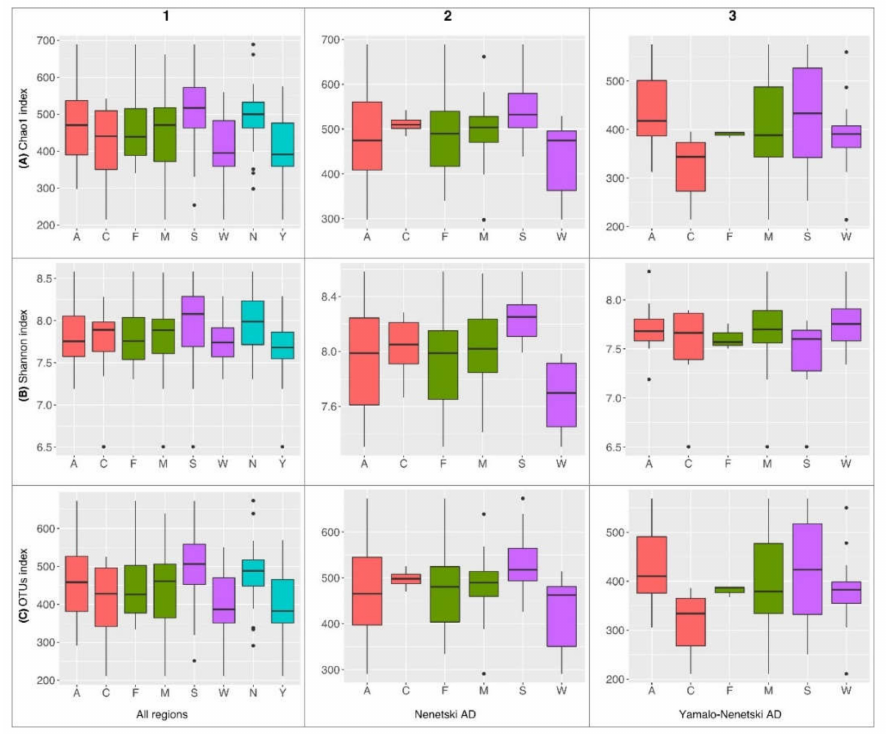
Figure 4. Box plot diagram of the alpha diversity indices of the ruminal microbial population in reindeer from Russian Arctic zones. Red plots reflect the differences between adults (A) and calves (C); green plots reflect differences between females (F) and males (M); purple plots reflect differences between seasons (S—summer, W—winter); and blue plots reflect differences between regions (N— Nenetski AD; Y—Yamalo-Nenetski AD). The first column of graphs (1) reflects the differences in both regions studied; the second column (2) reflects the internal differences in the Nenetski AD; the third column (3) reflects internal differences in the Yamalo-Nenetski AD. The first set of raw graphs ( A ) reflects the ChaoI index, the second ( B ) reflects the Shannon index, and the third ( C ) reflects the operational taxonomic unit (OTU)